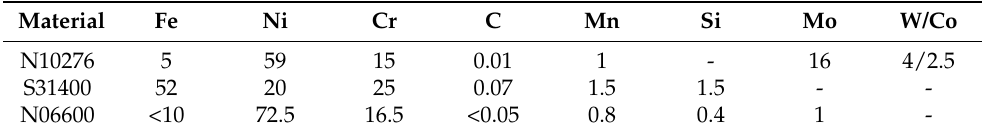
Table 2. Chemical composition of tested materials [wt.%].